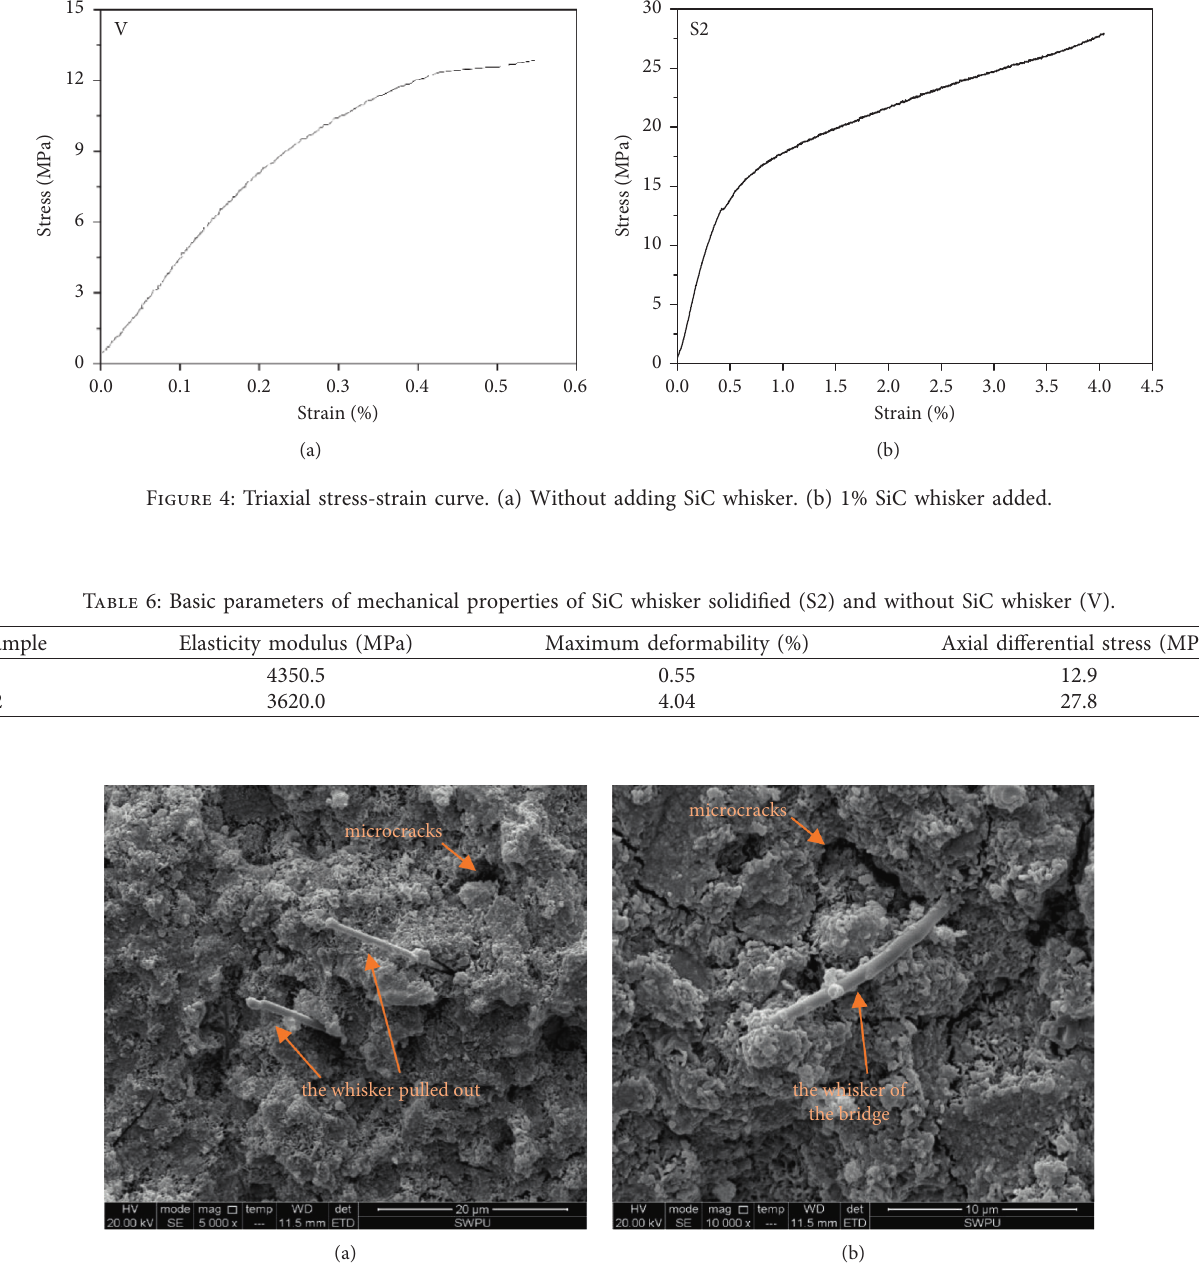
Figure 5: SEM micrograph of S2: (a) low magnification; (b) high